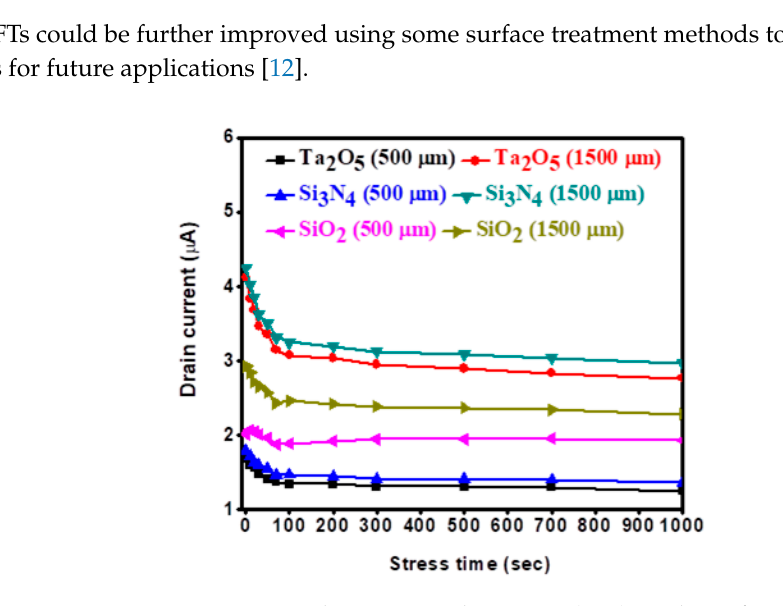
Figure 9. Drain current variation under a positive bias stress (PBS) condition for 1000 s with gate dielectric SiO 2 , Si 3 N 4 , and Ta 2 O 5 at different channel widths of 500 µ m and 1500 µ m. The positive stress voltage was +3V.